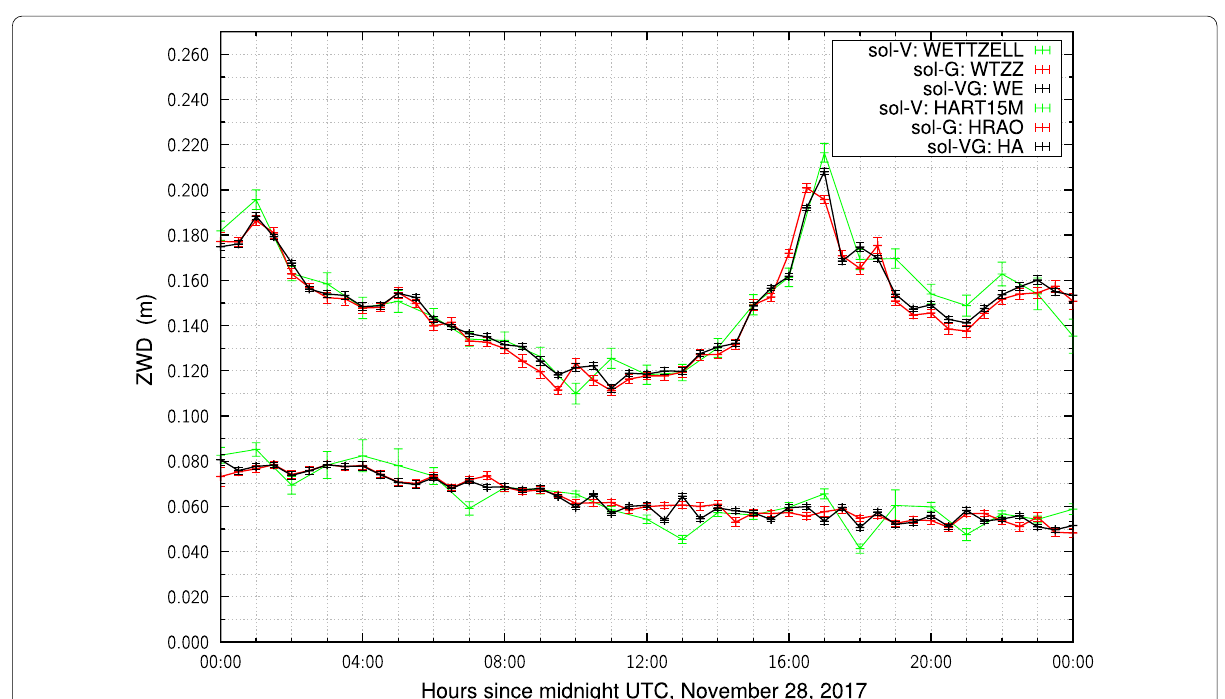
Fig. 9 ZWD estimates of sol‑V (green), sol‑G (red), and sol‑VG (black) for co‑located stations at two sites, HA (top) and WE (bottom)